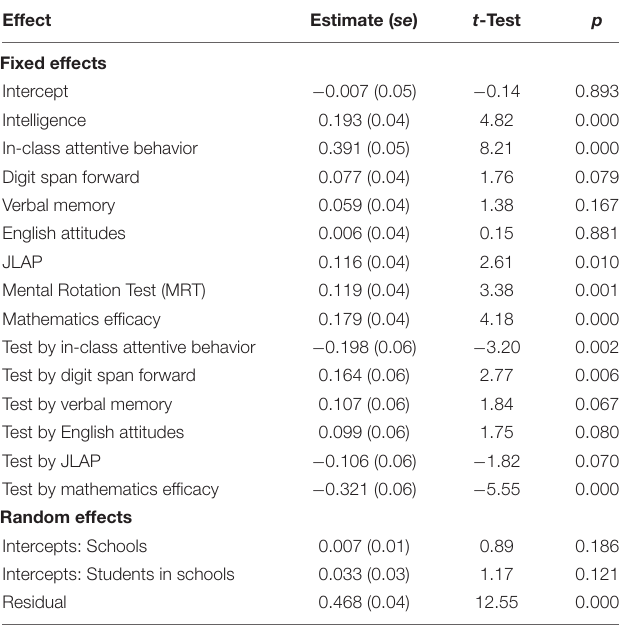
TABLE 6 | Estimates from multi-level model for Oral Reading Fluency and Numerical